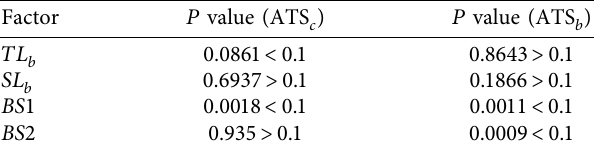
Table 5: ANOVA results (experiment 1).